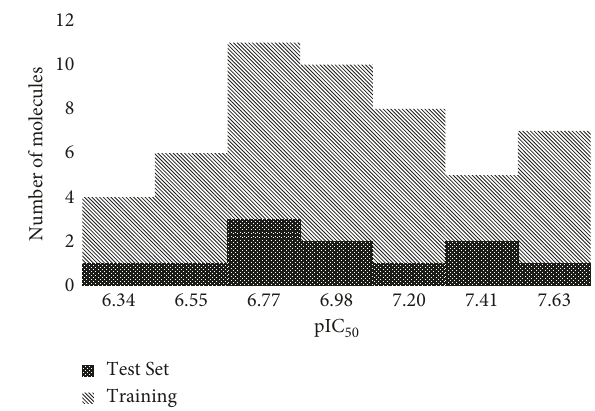
Figure 1: Distribution of experimental pIC training and test sets.